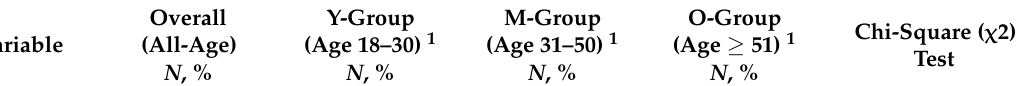
Table 1. Six main socio-demographic characteristics of the respondents by overall (all age) scenario and three fused age groups (Y: young age; M: middle age, O: old age). Valid percent is